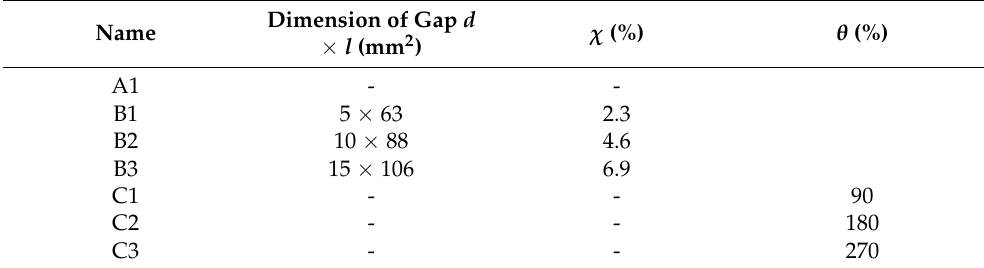
Table 1. Information of BWCFST short column